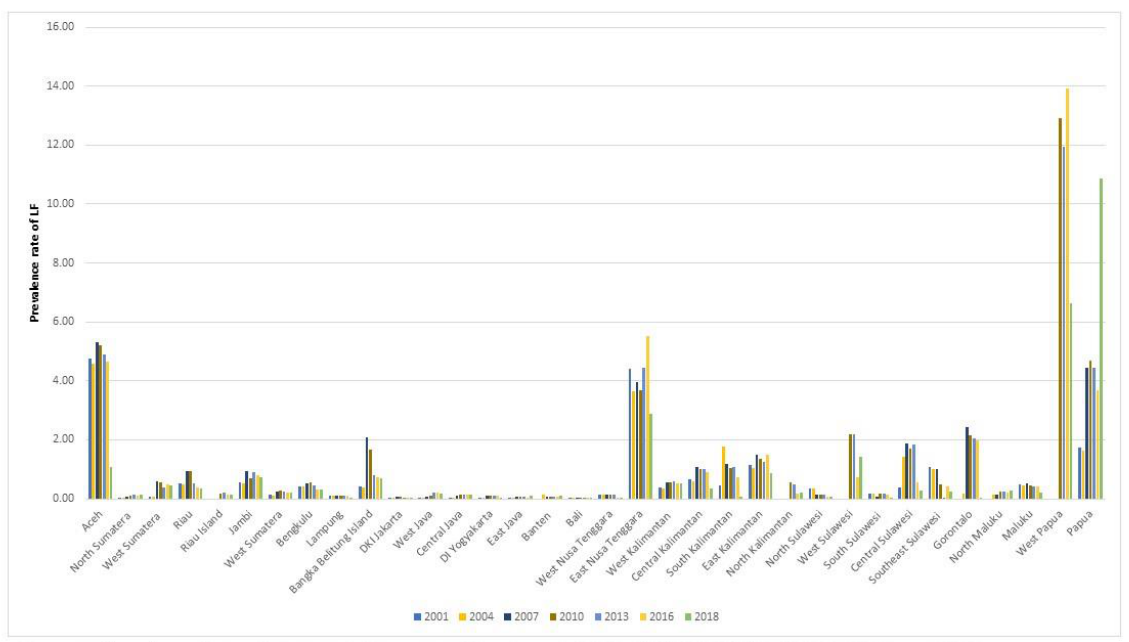
Figure 3. Prevalence Rate of Filariasis in Cases in 34 Provinces in 2001, 2004, 2007, 2010, 2013, 2016 and 2018.